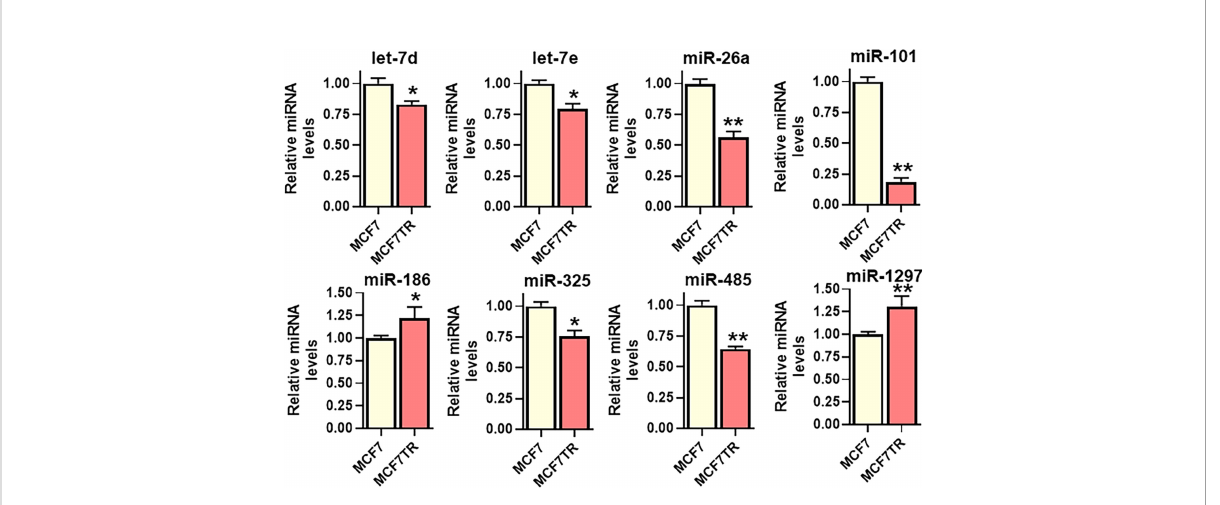
FIGURE 3 Identi fi cation of SNHG6 target miRNAs. Several miRNAs, as identi fi ed, were quantitated in MCF-7 and MCF7TR cells, using qRT-PCR. The levels of miRNAs in parental MCF-7 cells were assigned a value of 1 and the relative levels in tamoxifen-resistant MCF7TR are plotted. *p<0.05 and **p<0.01, compared to respective